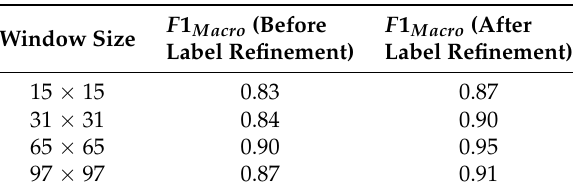
Table 3. F 1 score for Various Patch